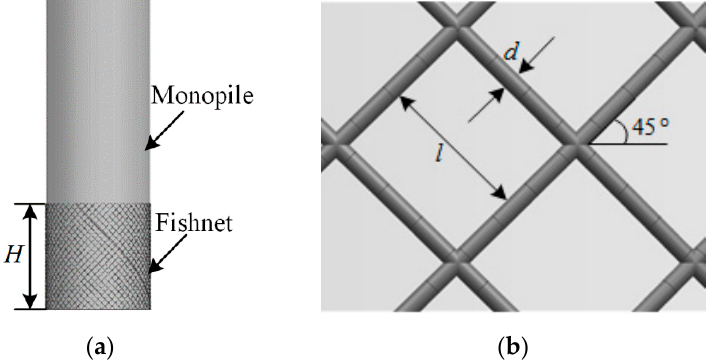
Figure 3. A numerical model of the monopile: ( a ) main view; ( b ) geometries of the fishnet.